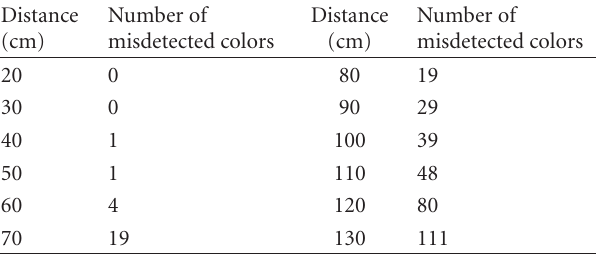
Table 1: Accuracy evaluation of the nonintrusive projection regarding the distance to the